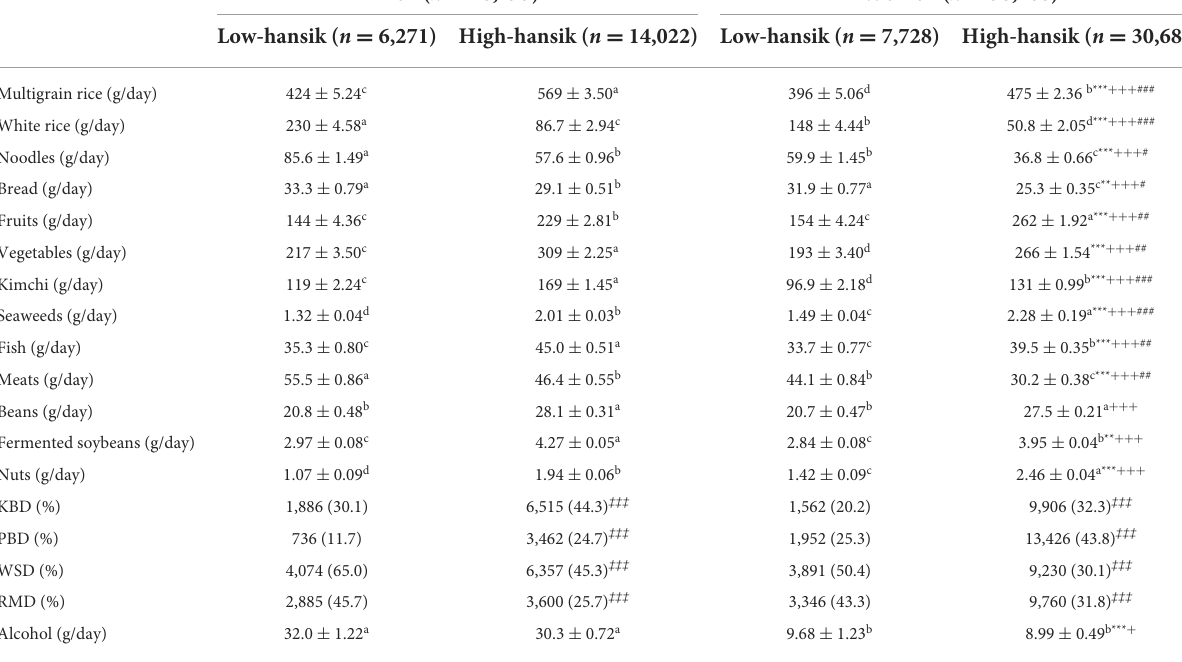
TABLE 3 Food intake according to gender and hansik intake defined by the K diet -index score.